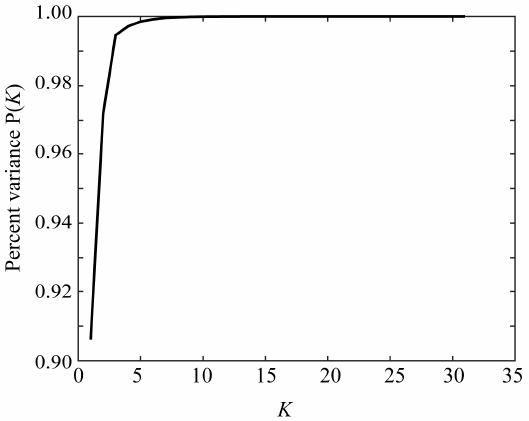
( ) P K ( K ) as a function of the number of principal component K as a function of the number of principal component K . Figure 13. Percent variance P